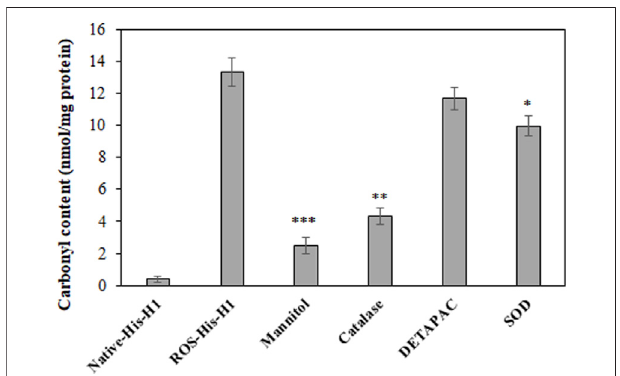
FIGURE 1 | Detection of carbonyl compounds in native and ROS-modi fi ed histone H1 protein. Quenching studies using mannitol (100 mM), catalase (500 units/ml), DETAPAC (100 mM), and SOD (500 units/ ml) were performed for the generation of carbonyl contents